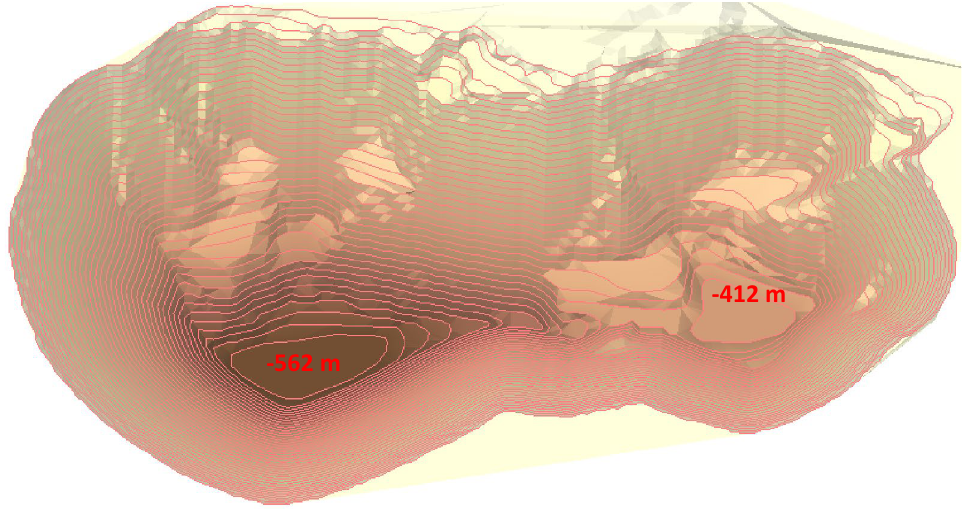
Figure 6. The ultimate pit of open pit mine.